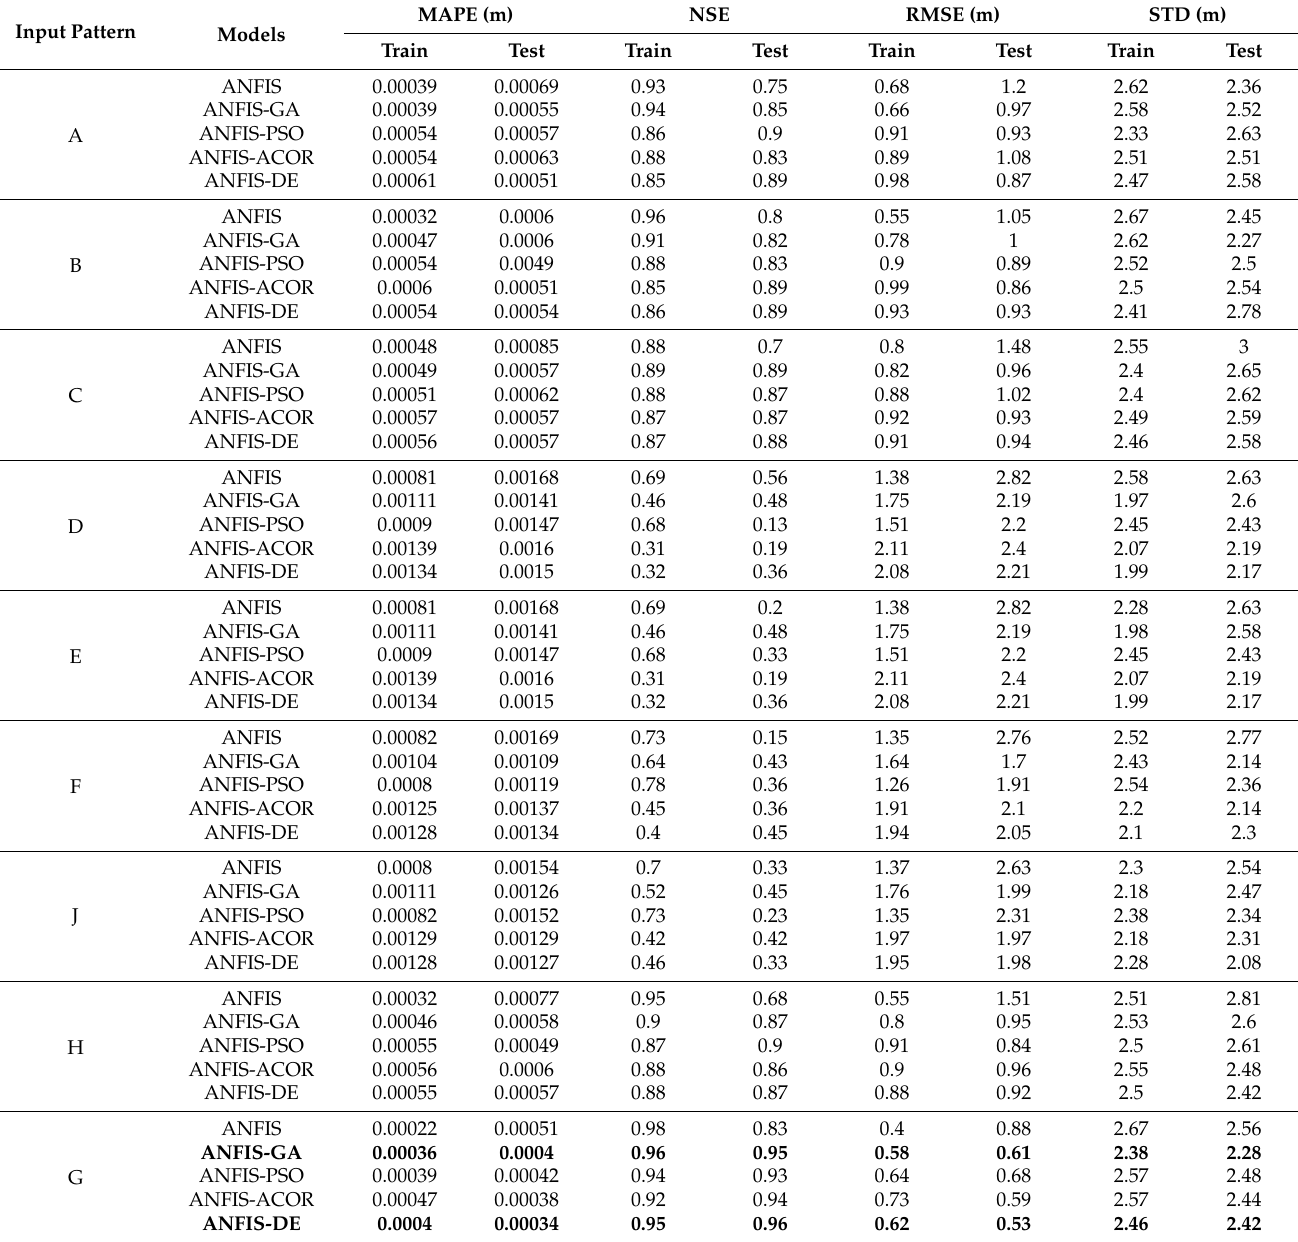
Table 7. Evaluation criteria of studied input patterns using different models for the observation well